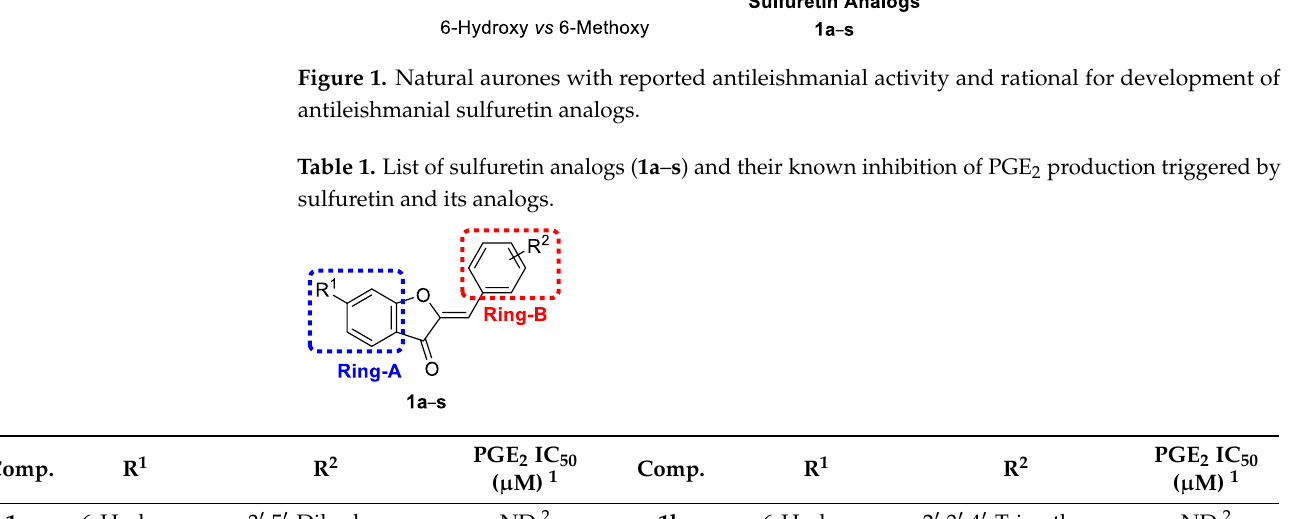
Table 1. List of sulfuretin analogs ( 1a − s ) and their known inhibition of PGE 2 production triggered by sulfuretin and its analogs.